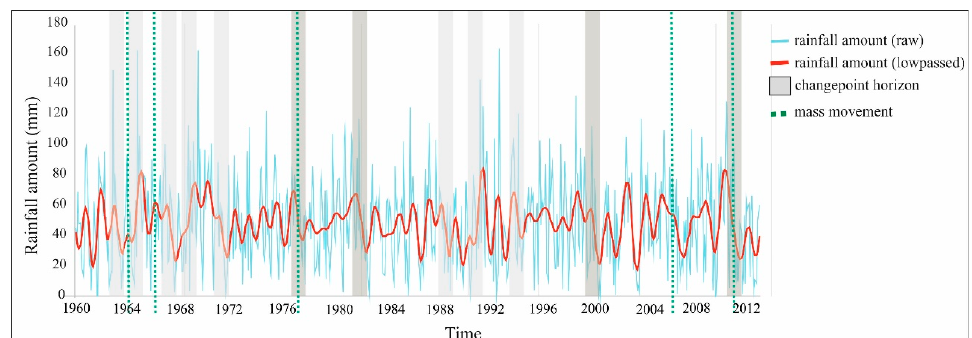
Figure 4. Results of changepoint analyses. The blue line shows the amount of rainfall, red is the 12-month low-passed rainfall amount, grey columns are the year in which the changepoints were found (darker grey areas are the significant changepoints with a posterior probability >95%) and the green line represents the mass movements.